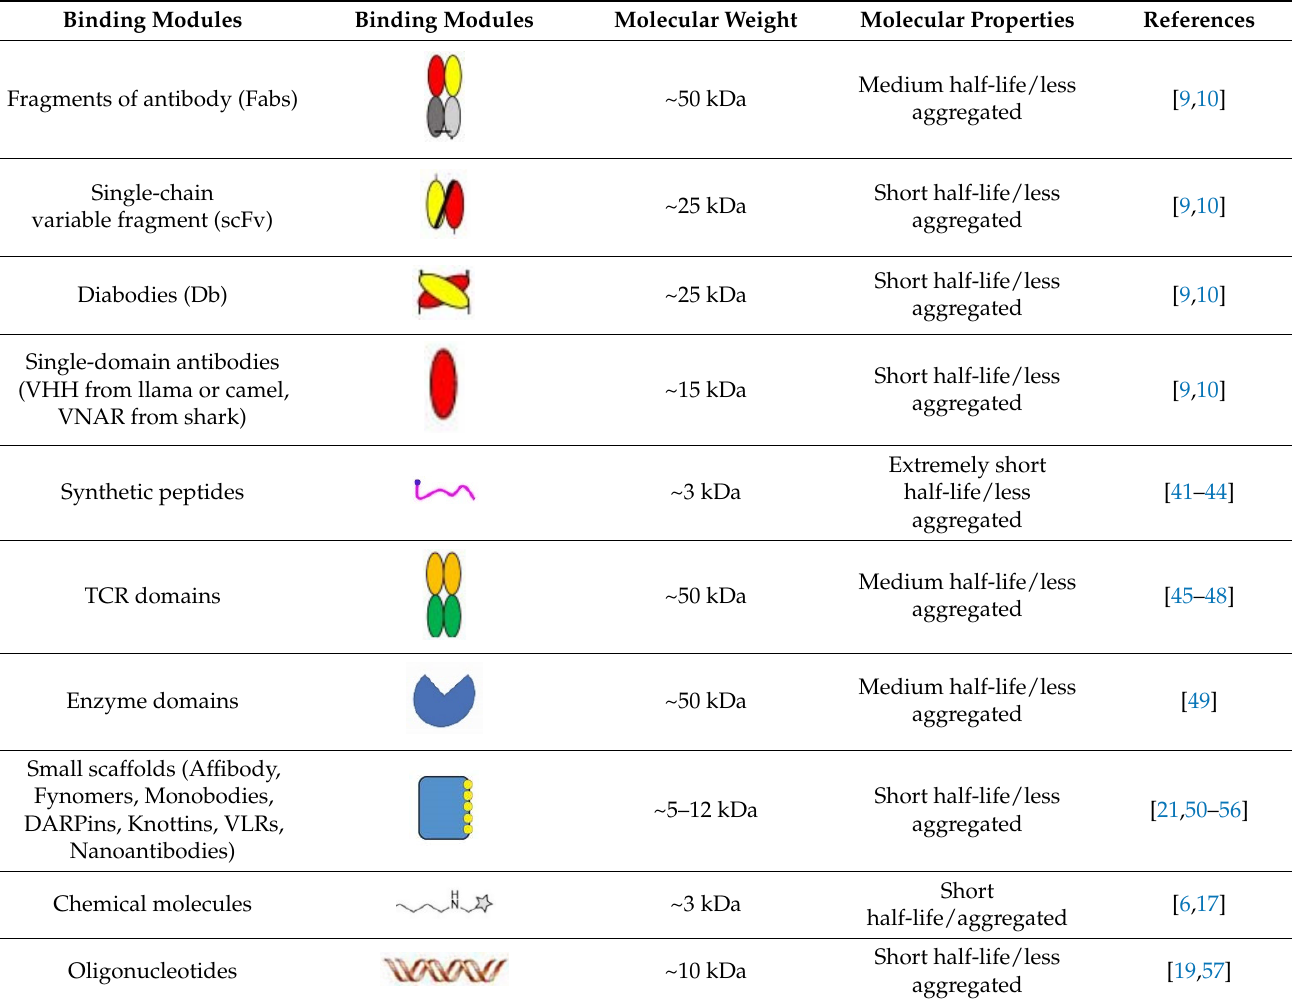
Table 1. Building blocks of multispecific biotherapeutics.